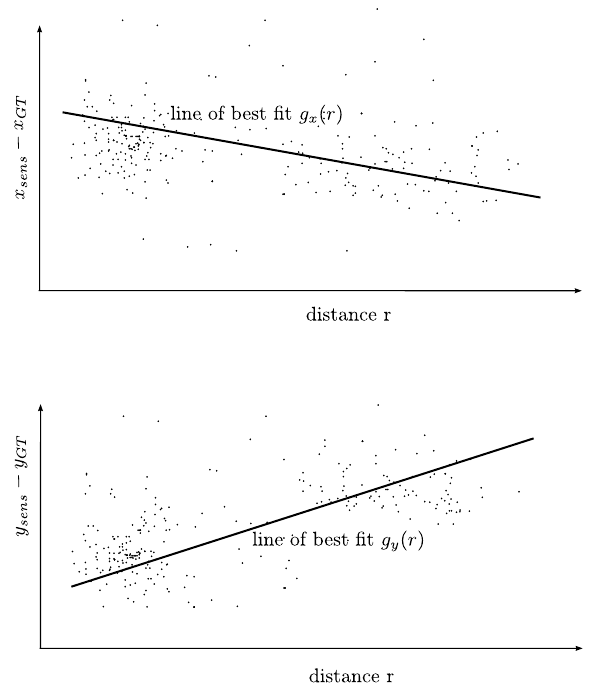
Figure 4. Schematic illustration of the scatterplot and the line of the best fit, which represents the distance-based